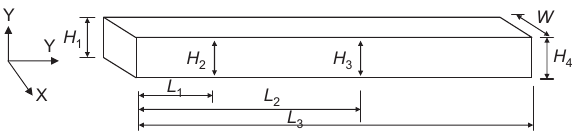
Figure 2 Parametric model used in geometric optimization.